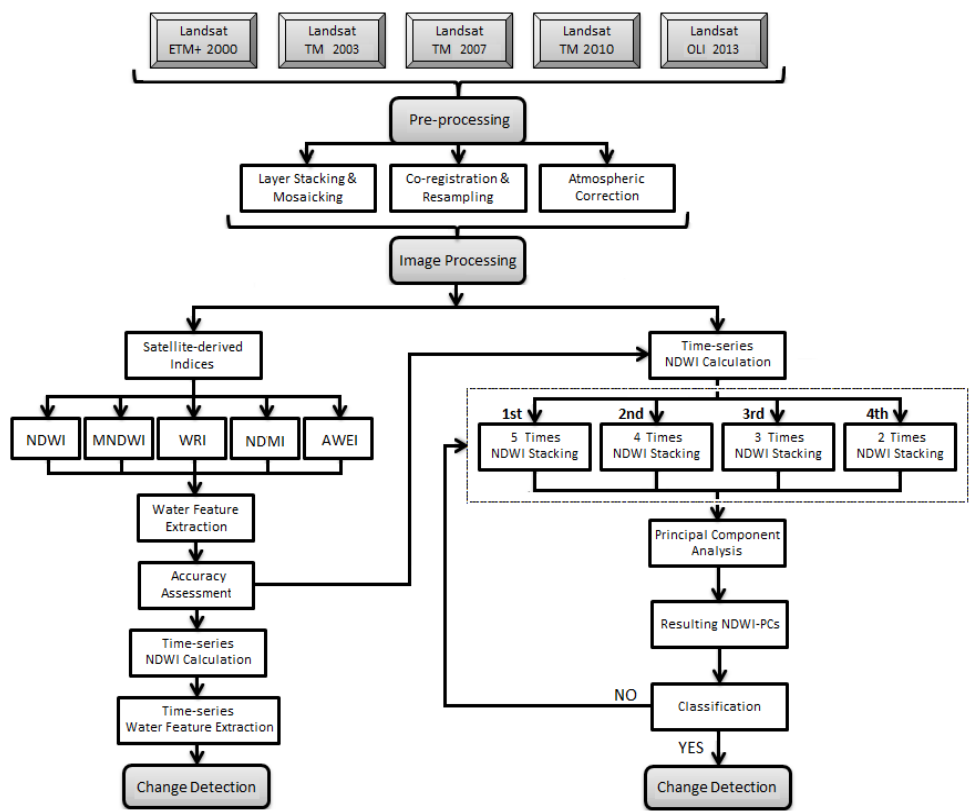
Figure 1. Flowchart showing the overall methods adopted in the